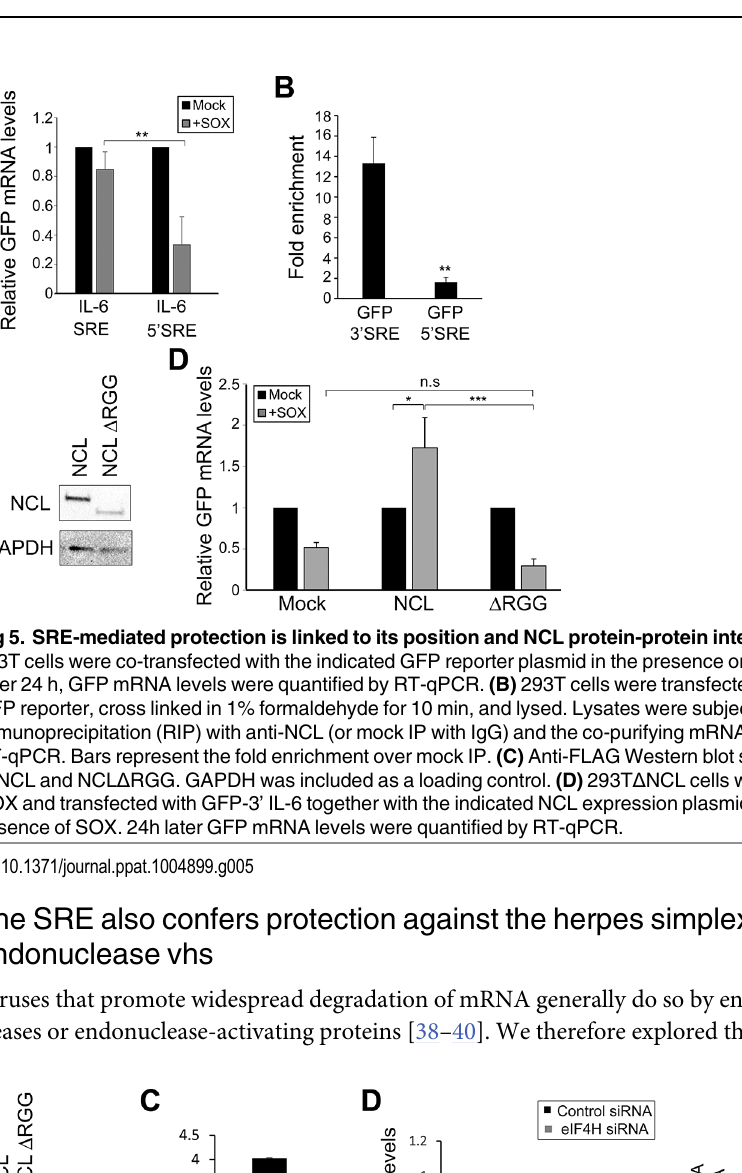
of NCL and NCL Δ RGG. GAPDH was included as a loading control. (D) 293T Δ NCL cells were treated with DOX and transfected with GFP-3 ’ IL-6 together with the indicated NCL expression plasmid in the presence or absence of SOX. 24h later GFP mRNA levels were quantified by RT-qPCR.